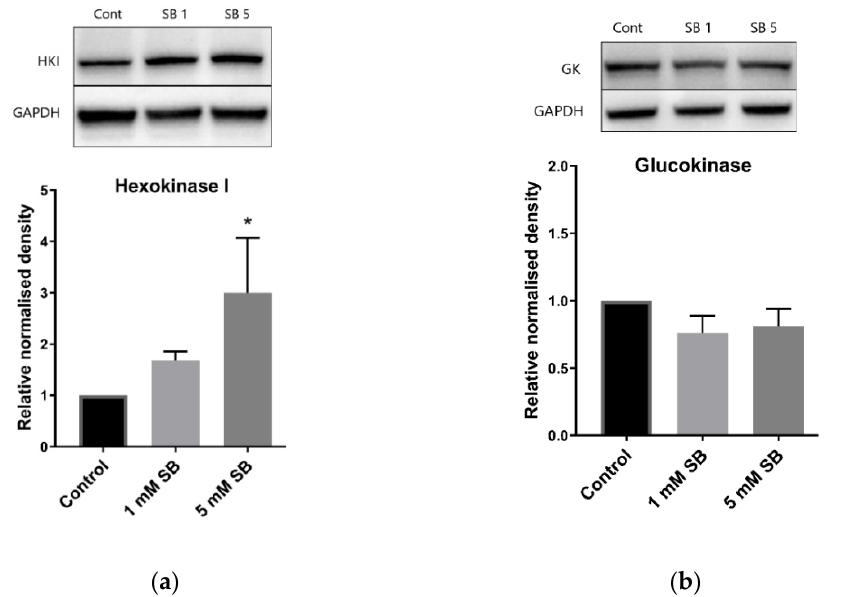
Figure 4. BRIN-BD11 immunoblots of hexokinases. Relative protein levels of ( a ) hexokinase I and ( b ) glucokinase in BRIN-BD11 cells following treatment with 1 mM or 5 mM sodium butyrate for 24 h. The graph represents the mean combined density readings as normalised to GAPDH from three independent experiments, with error bars representing SEMs. * p < 0.05.